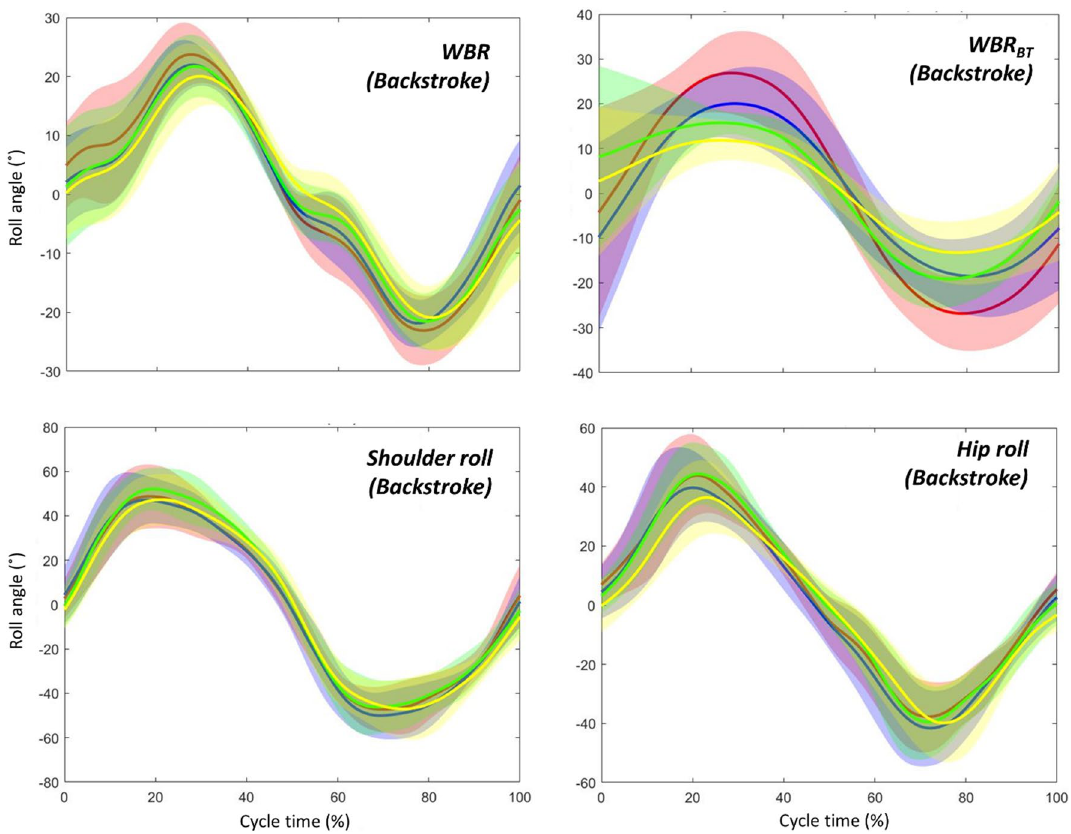
Figure 6. Time-series data (averaged among all participants) of the whole-body roll ( WBR ), whole-body roll due to the buoyant torque ( WBR BT ), shoulder roll, and hip roll in backstroke. Red, blue, green, and yellow lines show the averaged data at 83, 88, 93, and 100% of the maximal velocity trial, respectively, and the shaded area shows the inter-participant standard deviation.